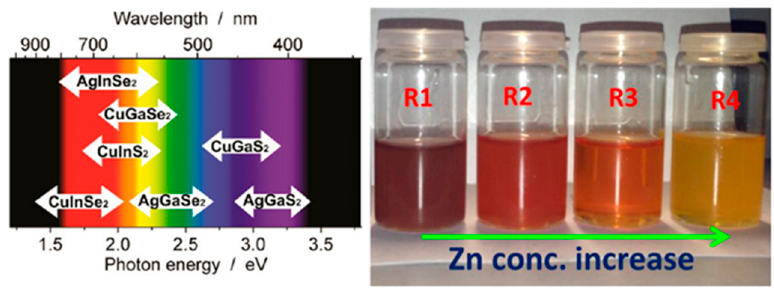
Figure 3. ( Left ) Optical bandgap for I-III-VI type nanocrystals (NCs) in the size range between 2 and 5 nm. Reproduced with permission from [106]. Copyright AIP Publishing, 2009. ( Right ) Photographs of Cu-In-Zn-S (CIZS) nanorods (NRs) with various zinc concentrations. Reproduced with permission from [19]. Copyright American Chemical Society, 2015.